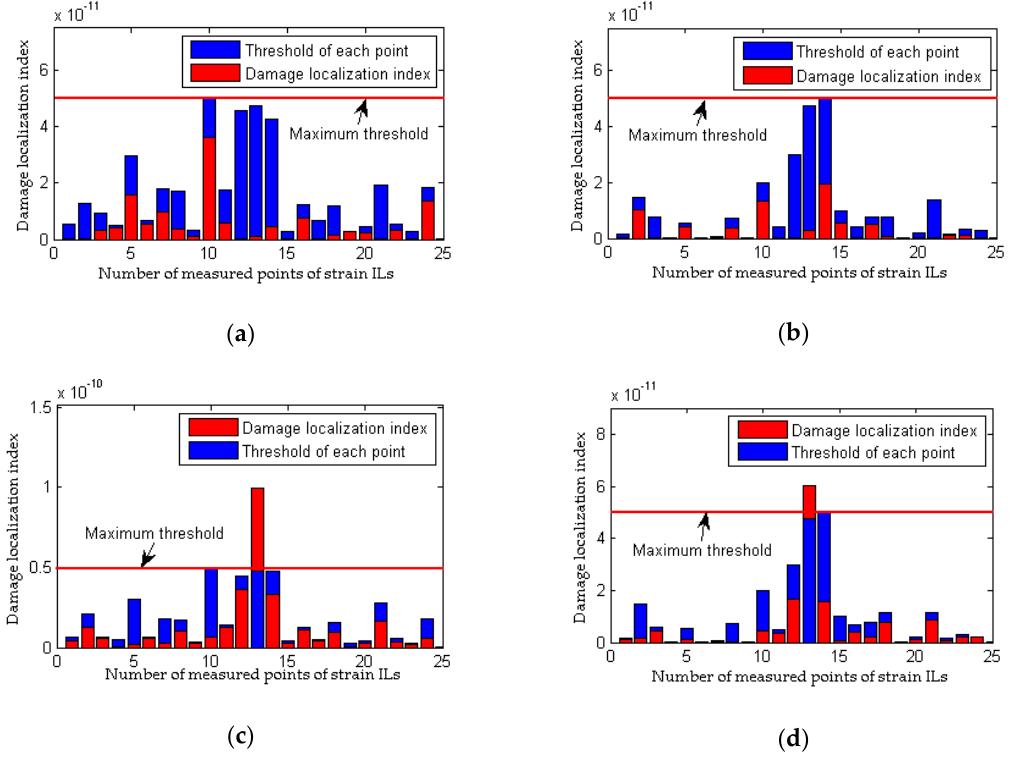
Figure 22. Results of the proposed method for the model bridge considering the effect of loading condition: ( a ) results of the #1 beam for experimental case 3; ( b ) results of the #2 beam for experimental case 3; ( c ) results of the #1 beam for experimental case 4; ( d ) results of the #2 beam for experimental case 4.